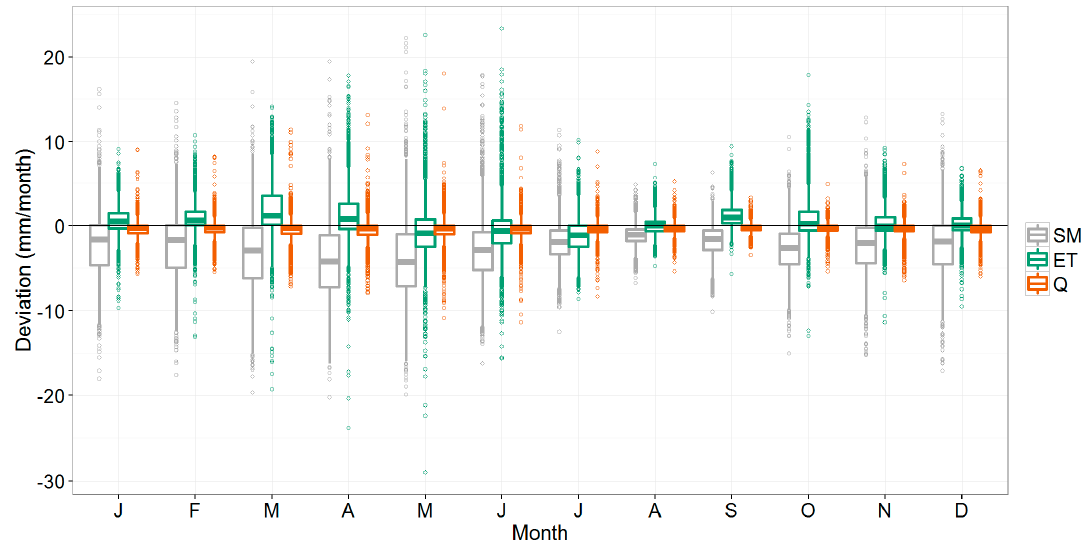
Figure 7. Boxplot showing the deviation (mm/month) of the 3_FAOseas method compared to the reference model for soil moisture (SM), actual evapotranspiration (ET), and streamflow (Q) at the sub-basin-scale. The variability shown corresponds to the interannual variability of all sub-basins. Table 3. Absolute and relative deviations for the 3_FAOseas run compared to the 0_NDVIref run, indicating the 10th, 50th (median) and 90th percentiles, for the basin and the sub-basin scale. Scale